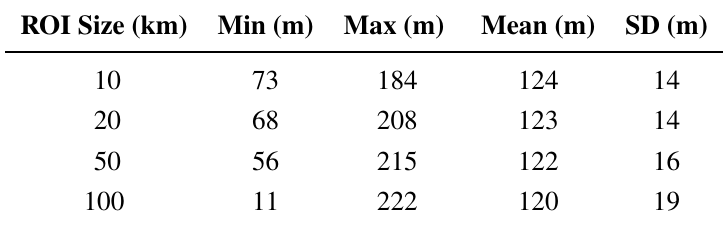
Figure 2. Twenty kilometer-long west-east longitudinal elevation profile over Libya-4 passing through the site center. Distances are given in meters. Table 1. Statistical elevation values over the 10 km × 10 km, 20 km × 20 km, 50 km × 50 km and 100 km × 100 km ROIs.